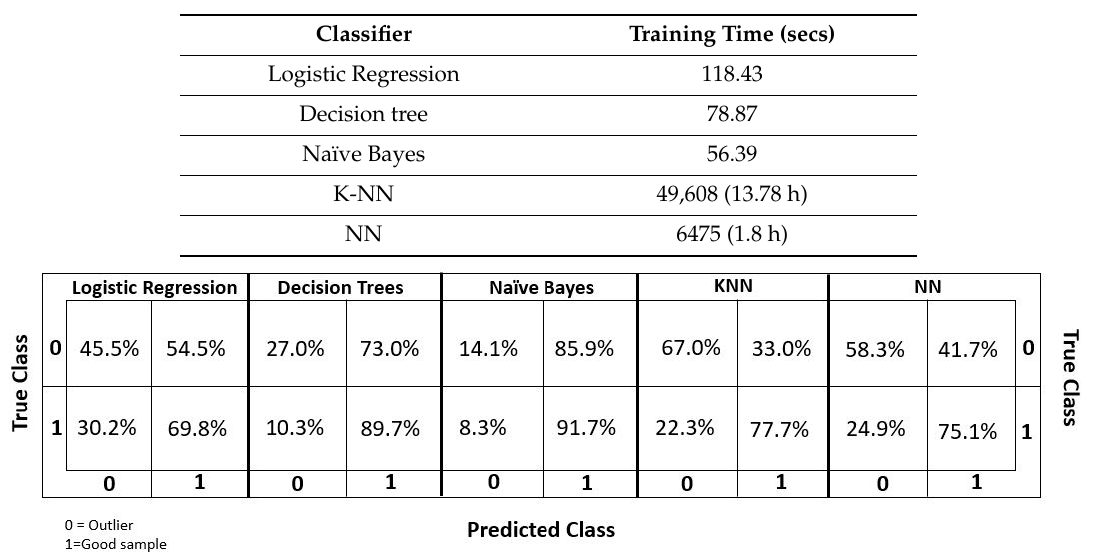
Table 2. Training time required for individual classifiers (top). Confusion matrices for different classifiers (bottom).